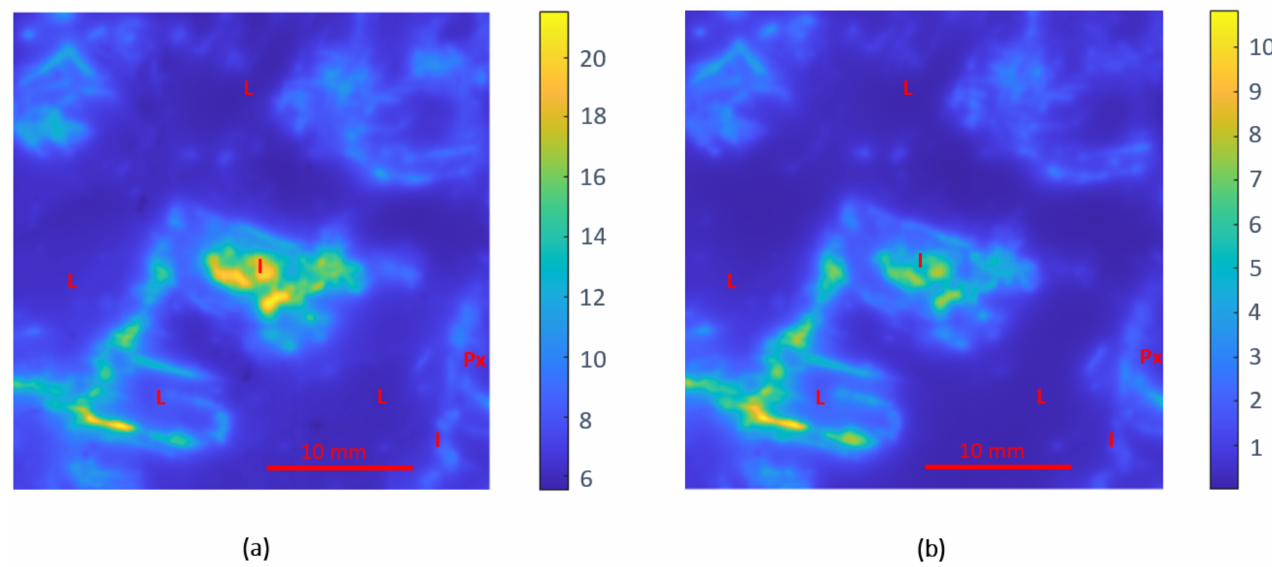
Figure 8. Dielectric images of the anorthosite specimen: ( a ) dielectric constant response and ( b ) loss factor results (L—labradorite plagioclase; Px—pyroxene;